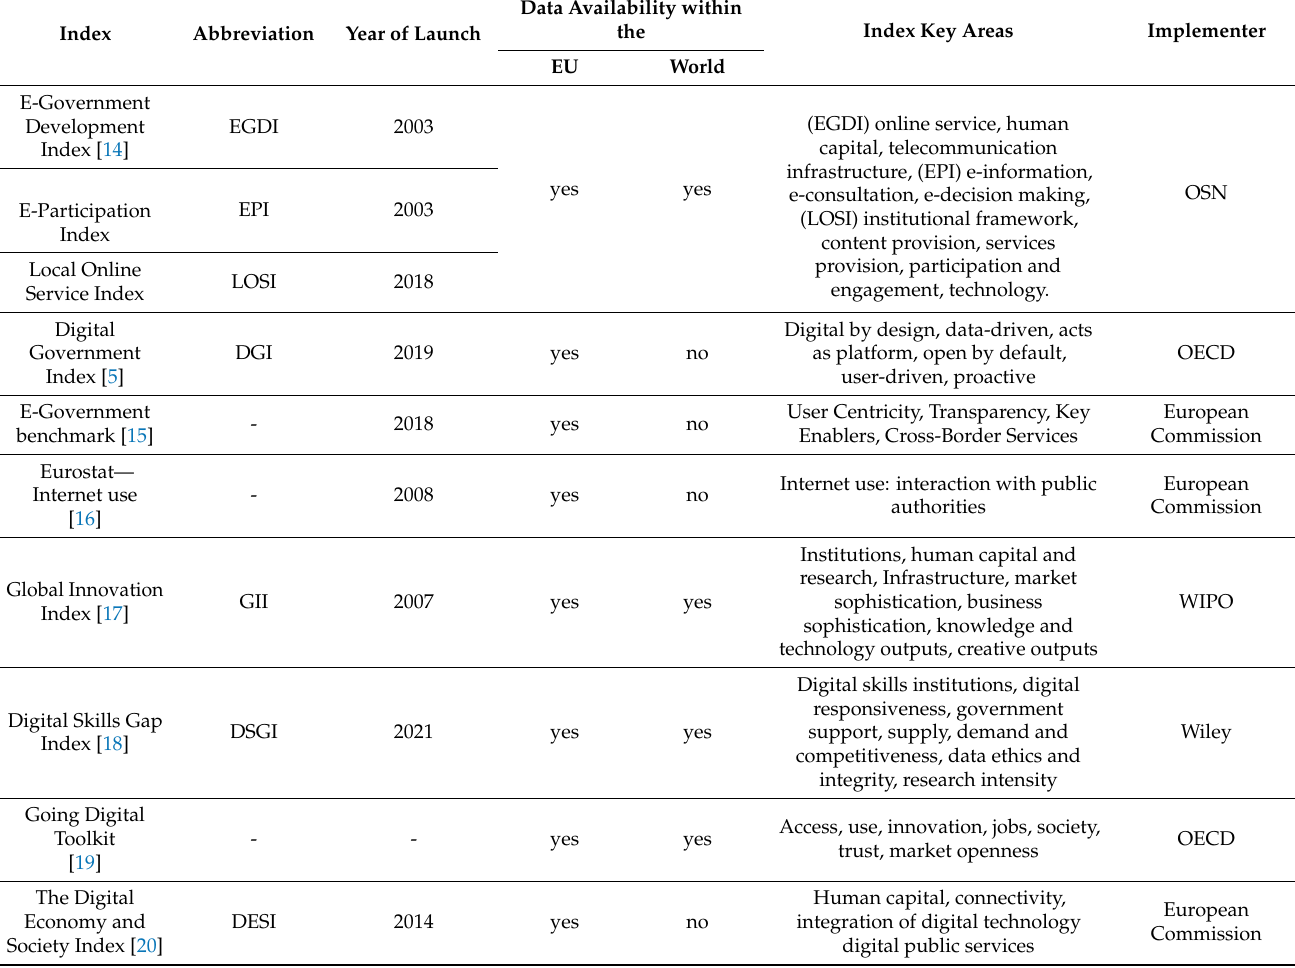
Table 2. Summary of the digitalization and e-Government